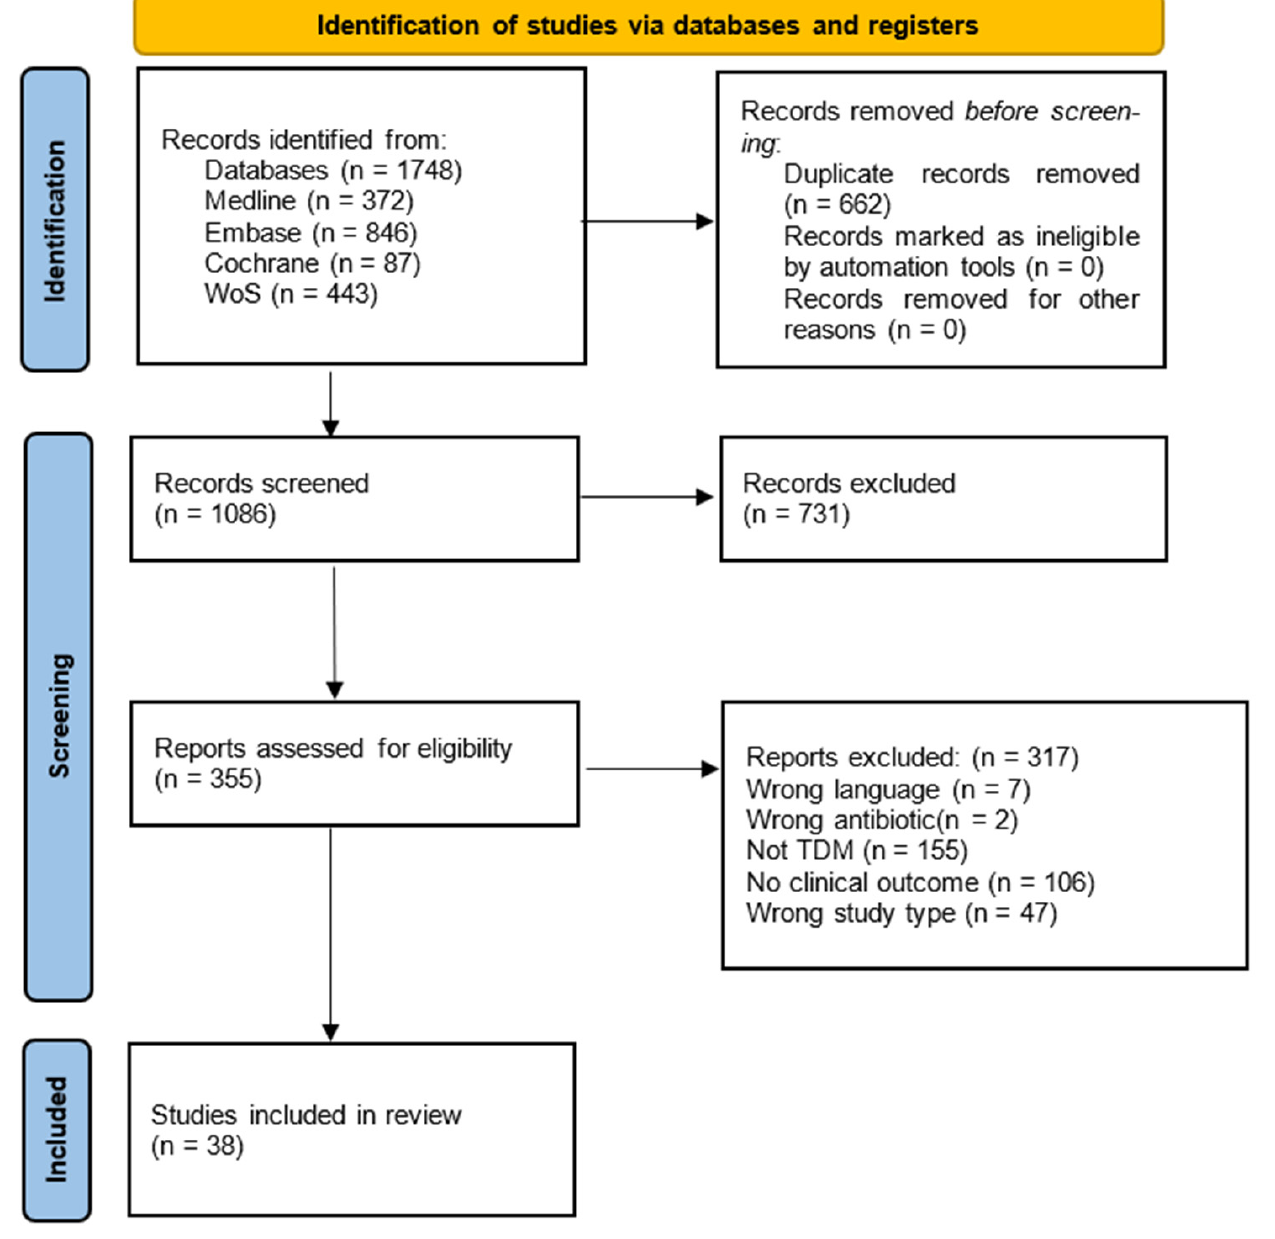
Figure 1. Literature search process in accordance to the Preferred Reporting Items for Systematic Reviews and Meta-Analyses (PRISMA) guidelines